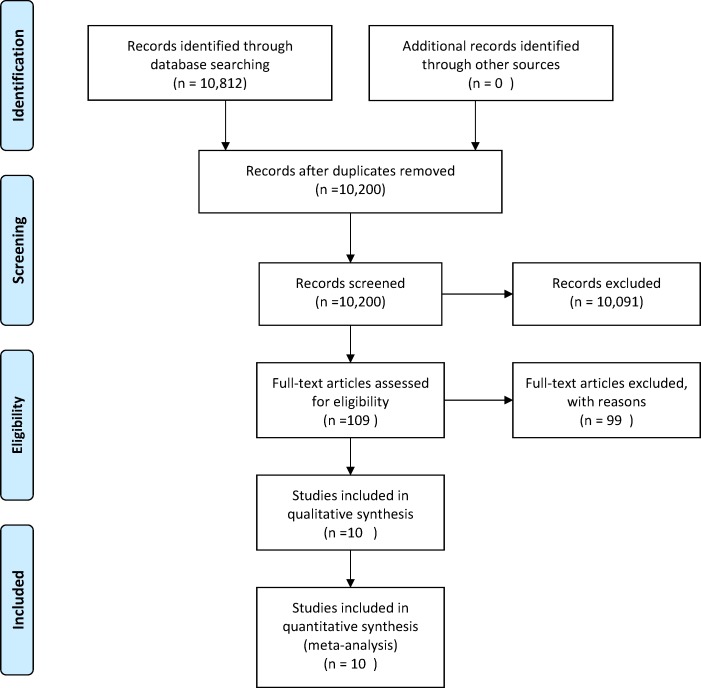
Flow diagram of study selection.